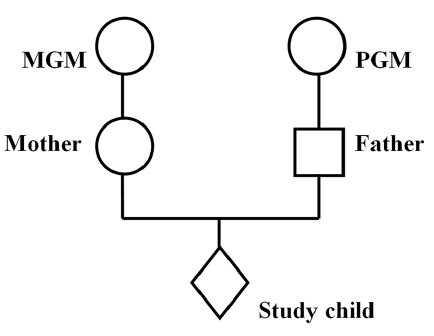
Figure 1. Diagram of intergenerational